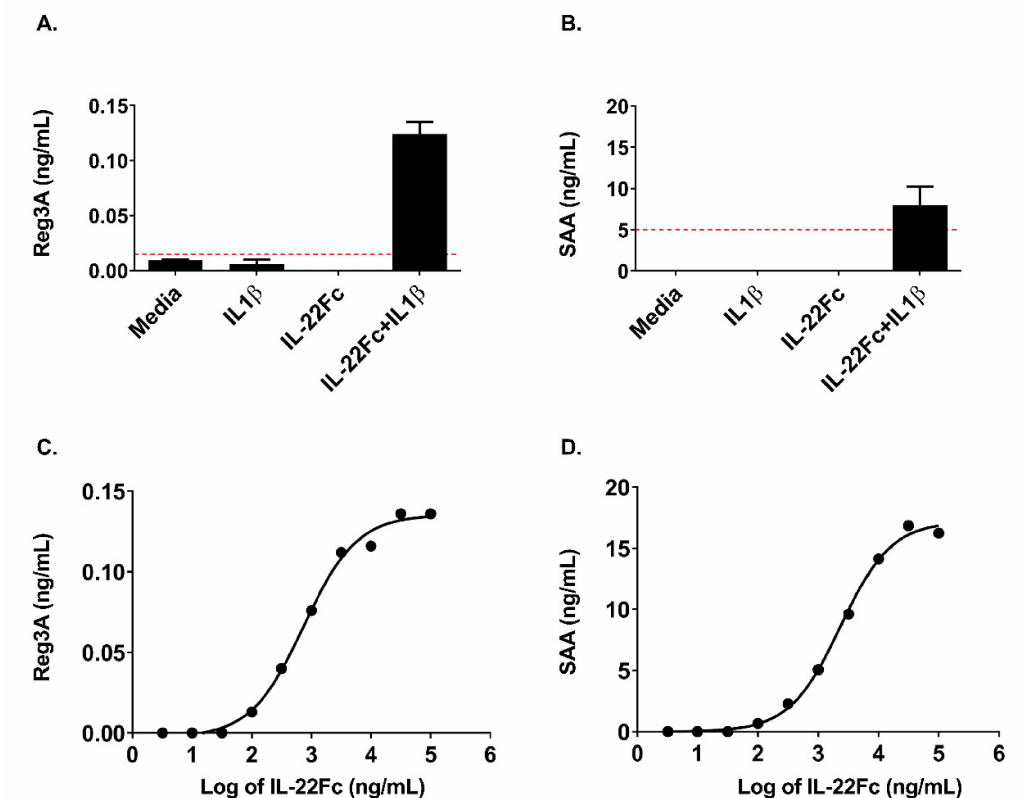
Figure 5. Secretion of acute phase proteins by HT-29 cells requires IL-1 β . ( A ) REG3A (Pancrepap), as measured by ELISA, showing detectable levels only with the addition of IL-1 β , shown as the mean +/- SD, n = 2. The dashed red line indicates the LLOQ of the assay. ( B ) Serum Amyloid A (SAA), as measured by ELISA, showing detectable levels only with the addition of IL-1 β , shown as the mean +/- SD, n = 2. The dashed red line indicates the LLOQ of the assay. ( C ) REG3A (Pancrepap) representative dose–response curve, as measured by ELISA. The points represent the mean of the duplicate wells, EC 50 = 2.3 µ g/mL. ( D ) Serum Amyloid A (SAA) representative dose–response curve, as measured by ELISA. The points represent the mean of the duplicate wells, EC 50 = 0.74 µ